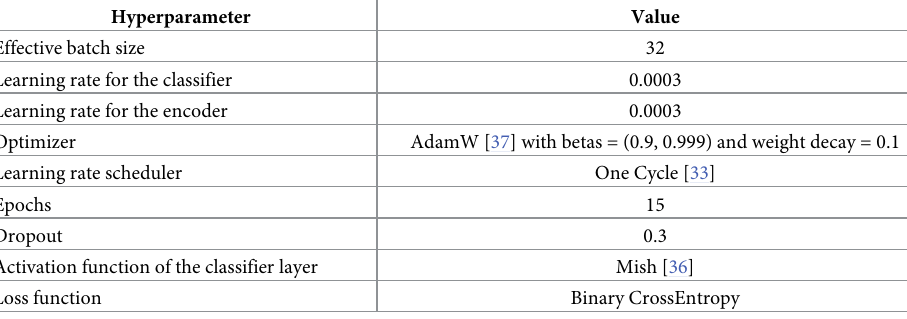
Table 4. Hyperparameters for the Big Bird